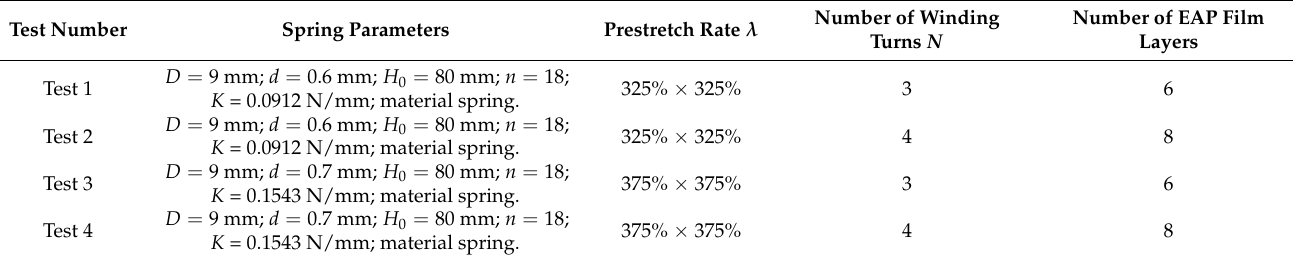
Table 5. Actuating unit test parameters.